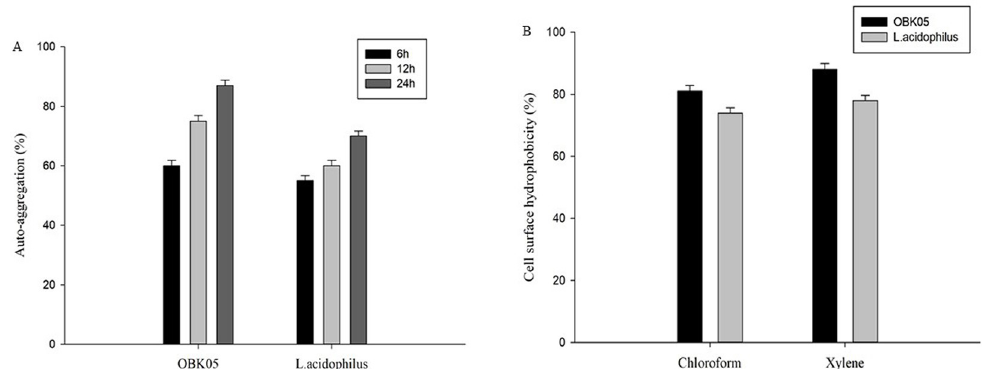
Fig 2. Aggregation ability of P . pentosaceus OBK05 and L . acidophilus . (A) Auto- aggregation ability (B) Cell surface hydrophobicity. Experiments were carried out in triplicates, and data with Error bars representing the Mean ± S.D. values of the independent investigation (p <